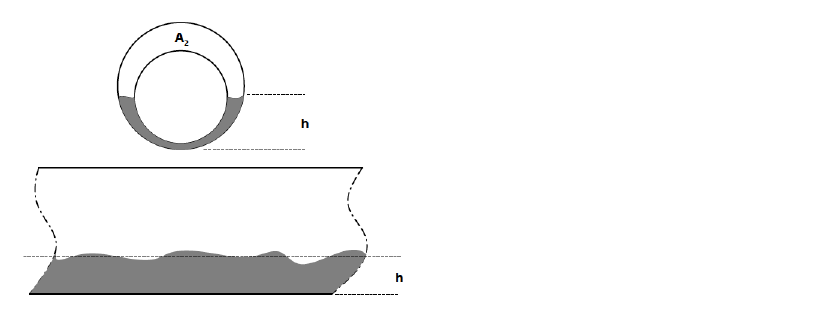
Figure 6. Schematic representation of calculating Carbopol layer thickness and volumetric